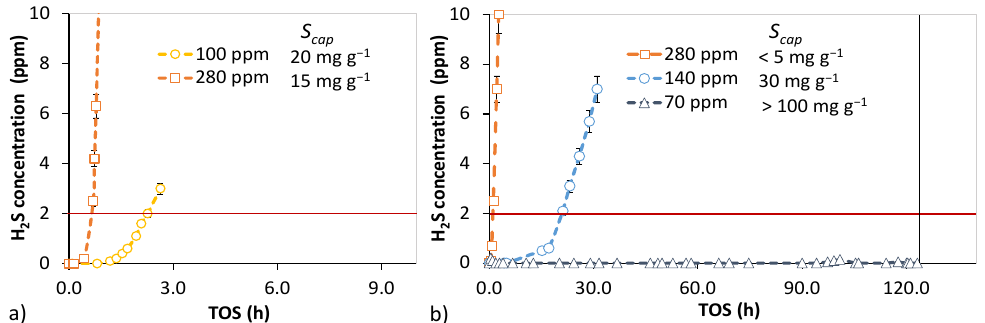
Figure 3. Effect of sulfur concentration on H 2 S breakthrough in oxygen-containing and moist syngas. ( a ) IAC at SV 24,000 h −1 in reactor 1. Particle size distribution—0.3–1.0 mm. ( b ) Non-impregnated activated carbon (AC1) at SV 3700 h −1 in reactor 2. Particle size distribution—1.0–1.25 mm. A vertical black line indicates premature termination.